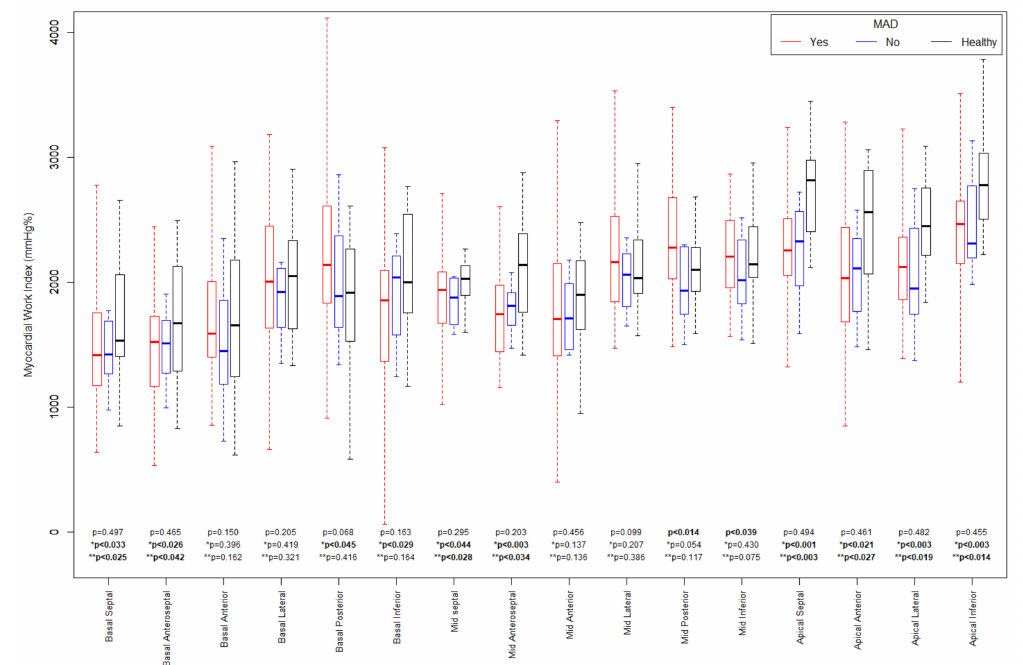
Figure 6. Myocardial Work Index comparisons between MAD+, MAD − and Healthy groups in sixteen